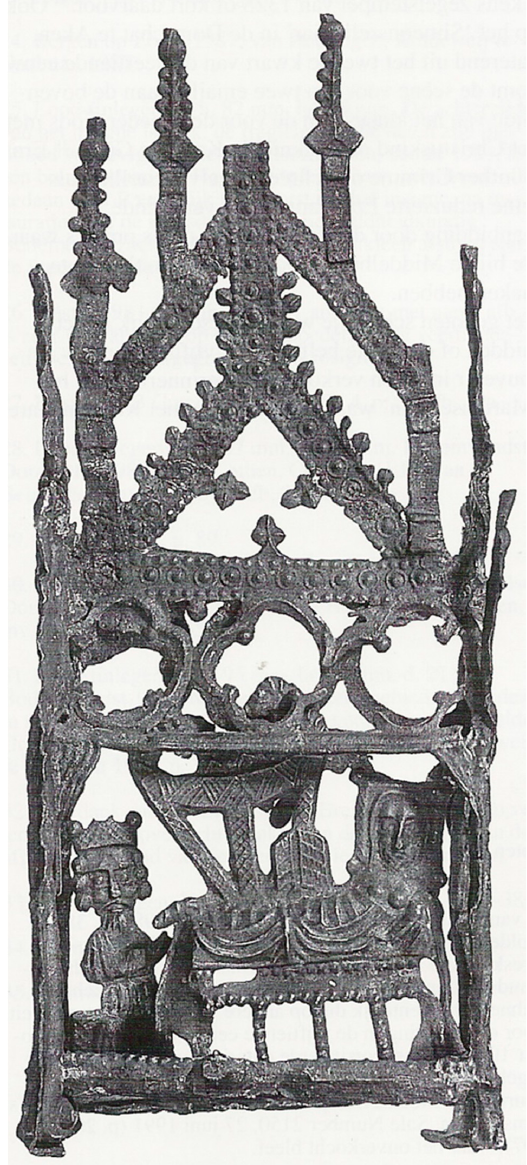
Figure 8. Pilgrim souvenir diorama with Charlemagne kneeling before the Virgin and Child, 14th century. Photo: After Koldeweij, “Karel de Grote-souvenirs”, pp. 124–26, pl. 10.